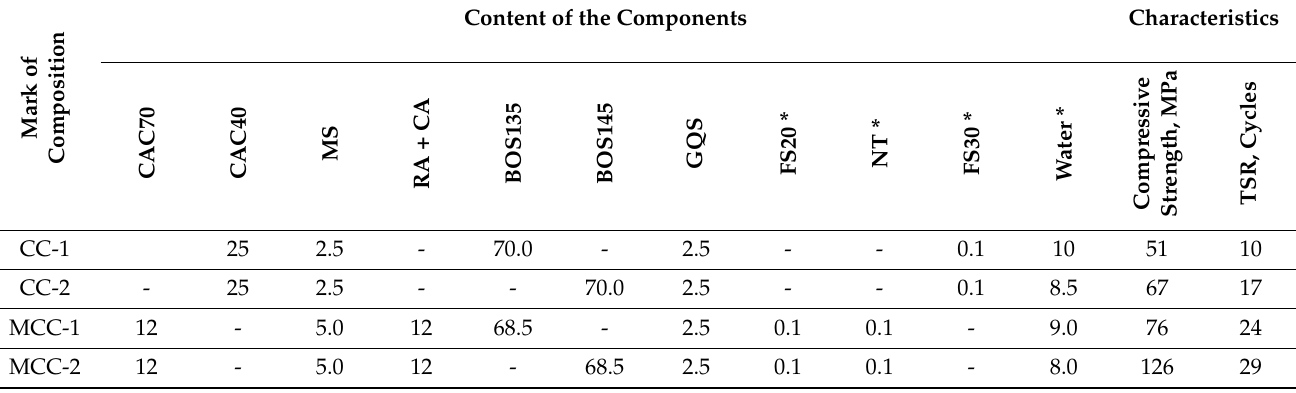
Table 1. Compositions of castables (mass %) and their characteristics